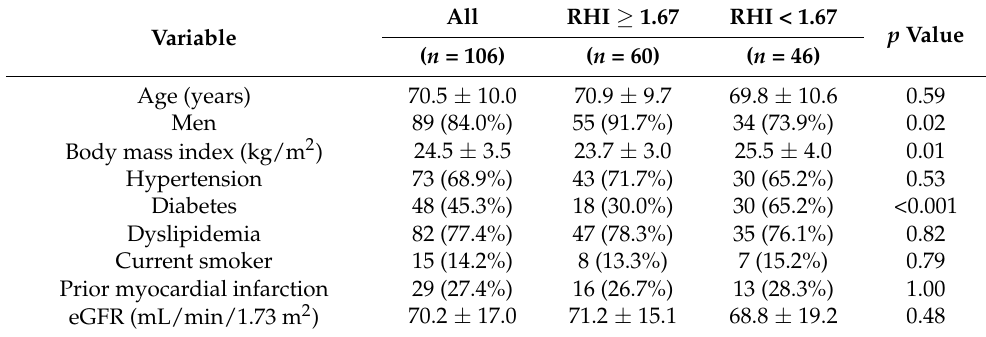
Table 1. Baseline